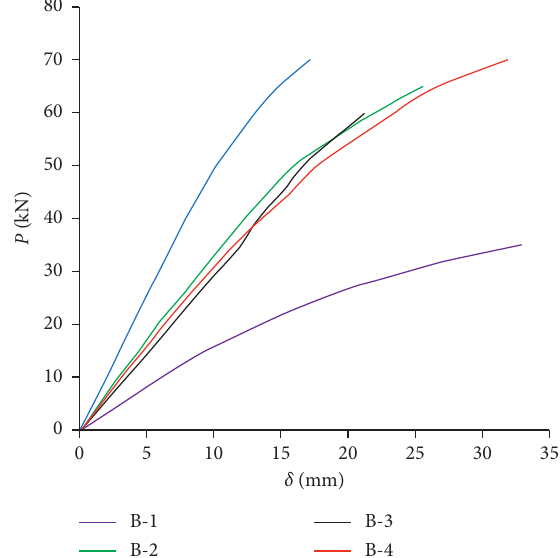
Figure 6: Load-deflection curves for specimens B-1 to